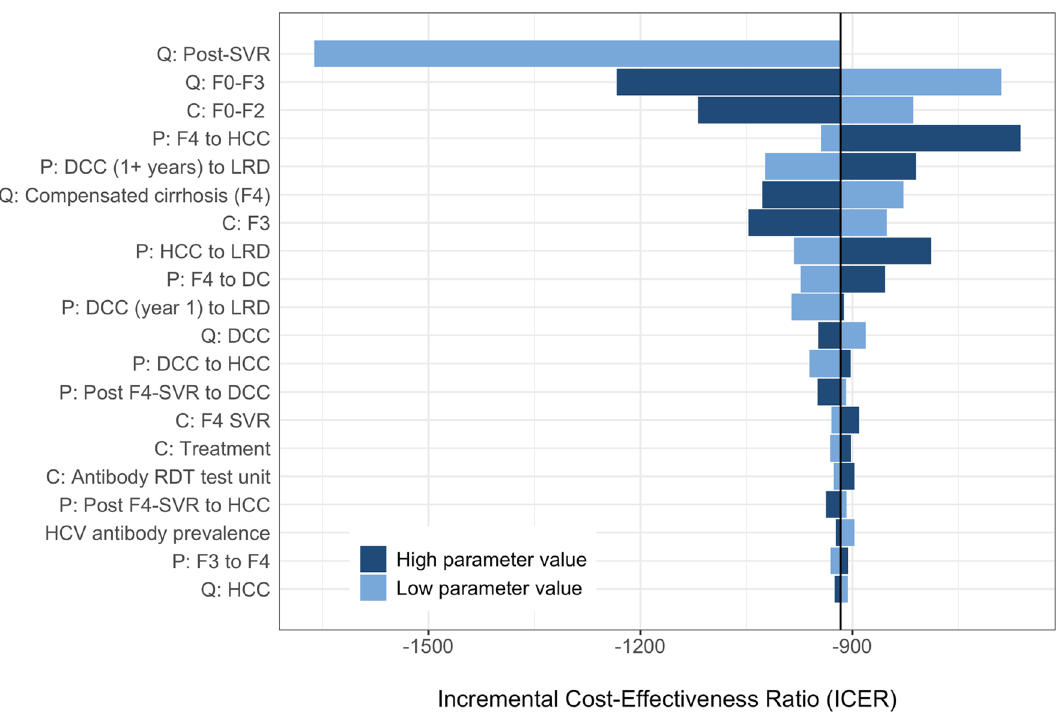
Figure 3. Tornado diagram for one-way sensitivity analysis of incremental cost-effectiveness ratio of Pathway 1 versus no screening strategy. Horizontal bars show the variation in incremental cost-effectiveness ratio (ICER; in USD/QALY) with variation in the value of the parameter. In the parameter names, the prefix ‘C’ represents cost of a health-state, ‘Q’ the quality-of-life weight and ‘P’ the transition probability from one state to the other. Values of ICER below 0 indicate that the treatment is cost-saving. Abbreviations: SVR, sustained virologic response; F0–F4, METAVIR fibrosis score; DC, decompensated cirrhosis; HCC, hepatocellular carcinoma; F4-SVR, LRD, liver related death.